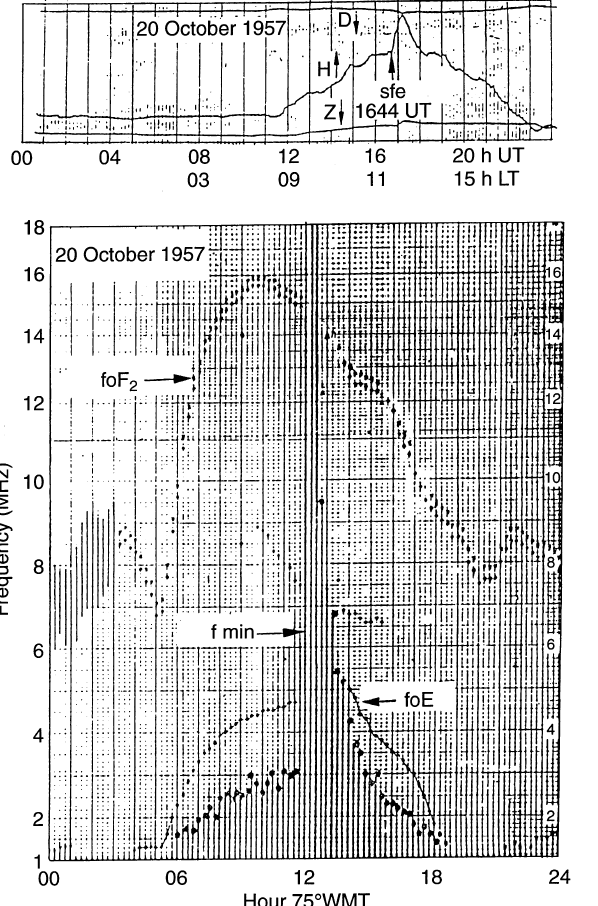
Fig. 11. Magnetograms and ionospheric f-plots at Huancayo asso- ciated with solar flare on October 20, 1957